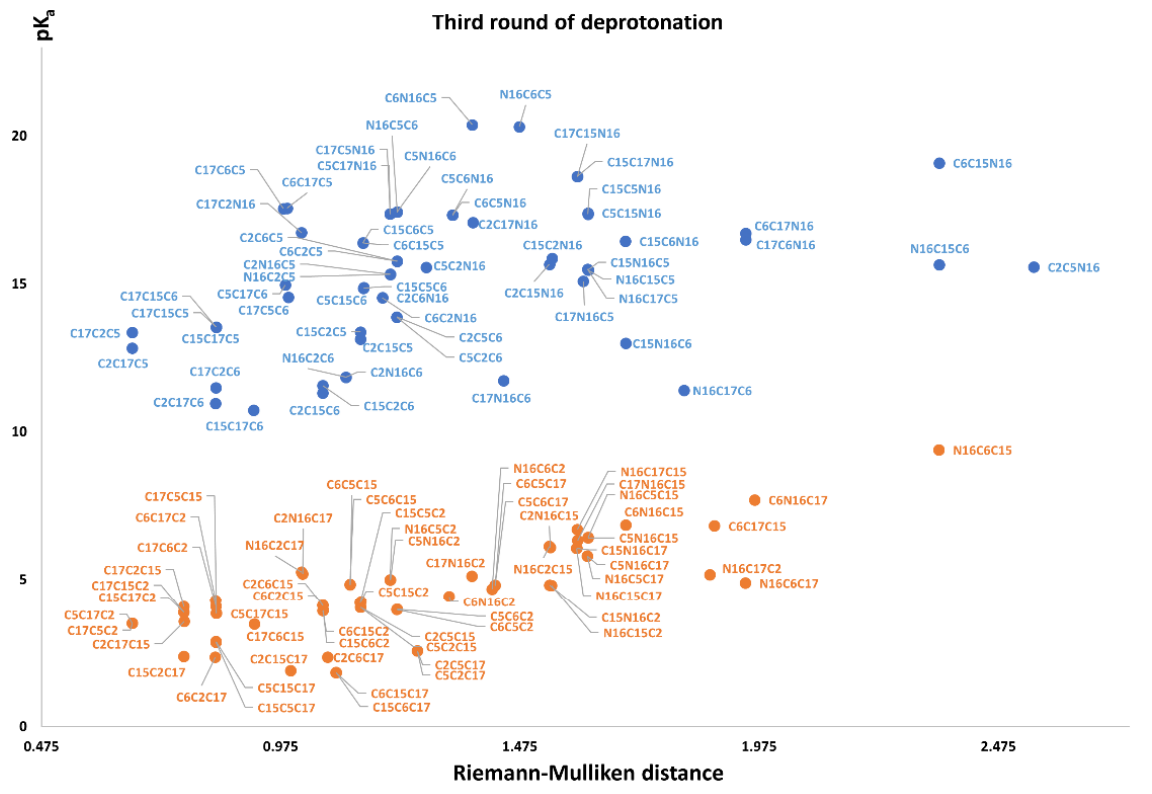
Figure 11. Relation between RMD and pK a values for all possible second deprotonation in Bd. The inferior cluster (orange) is strictly constituted by all the permutations of the low cluster in the second round (dihydropyridine ring nitrogen: C2, C15, C17) and the superior and inferior cluster of the first round. The complementary set constitutes the superior cluster (blue). Note that the third deprotonation follows a rule that can be used for optimization of the computations. The superior cluster does not require computations, be-